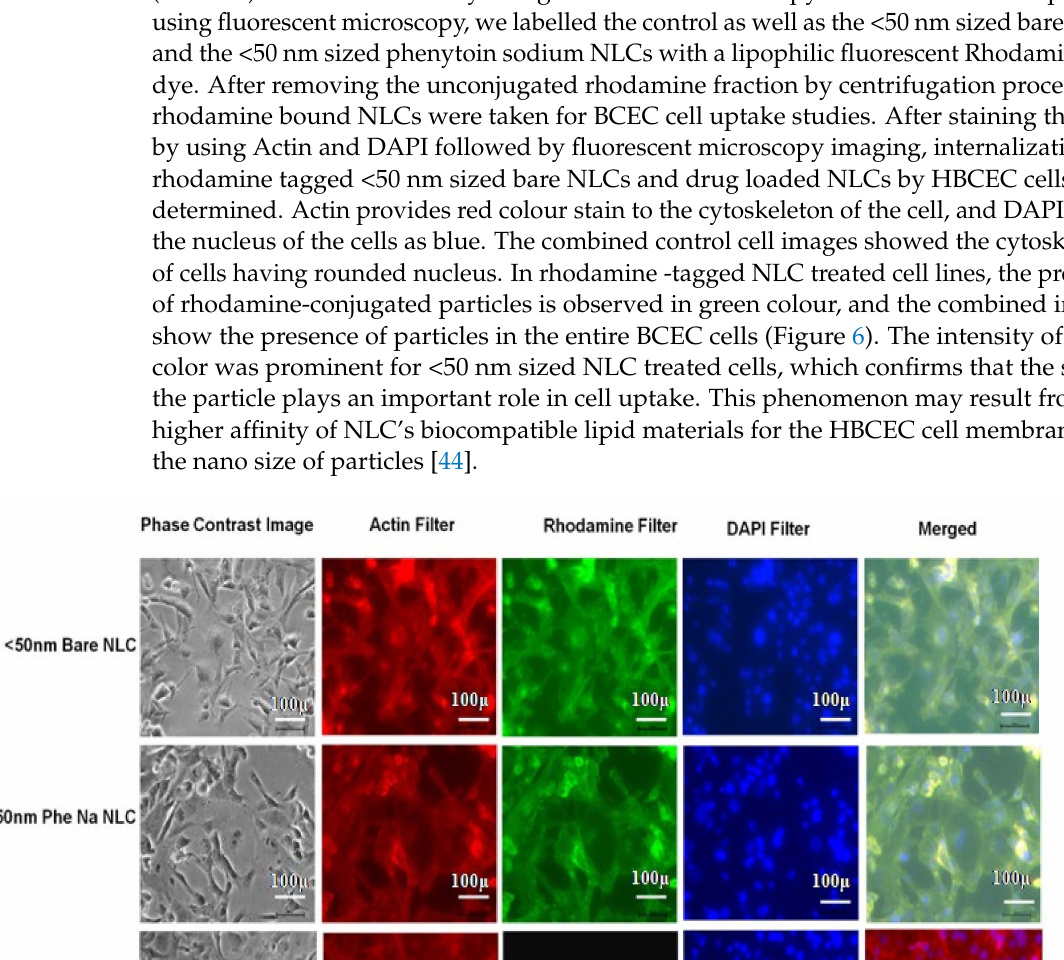
Figure 6. Fluorescent microscopic images showing the uptake of NLC by HBCEC cell line. 3.7. In Vivo Pharmacokinetic Study of Phenytoin Sodium NLCs in Wistar Rats In the in vivo pharmacokinetic study, the drug concentration was measured in plasma, CSF and the brain at regular intervals up to 1 h by using the validated HPLC method, and area under the curve (AUC) was also calculated. The HPLC method was fully validated for linearity. The linear response range for the plasma and CSF sample was found to be 20–90 µ g/mL and 100–600 µ g/mL, respectively, whereas the linear response range ob- tained was 50–700 µ g/g for the entire organ tissues sample. Figure 7A,B shows the plasma and CSF concentration-time profiles after intranasal administration of <50 nm phenytoin sodium NLCs, >100 nm phenytoin sodium NLCs, control drug solution, midazolam spray marketed formulation and IV administration of phenytoin sodium marketed formulation. The in vivo pharmacokinetic study showed that higher drug concentrations were observed in CSF within 5 min of intranasal administration of <50 nm sized phenytoin sodium NLCs than compared to the intranasal control drug solution and marketed phenytoin sodium